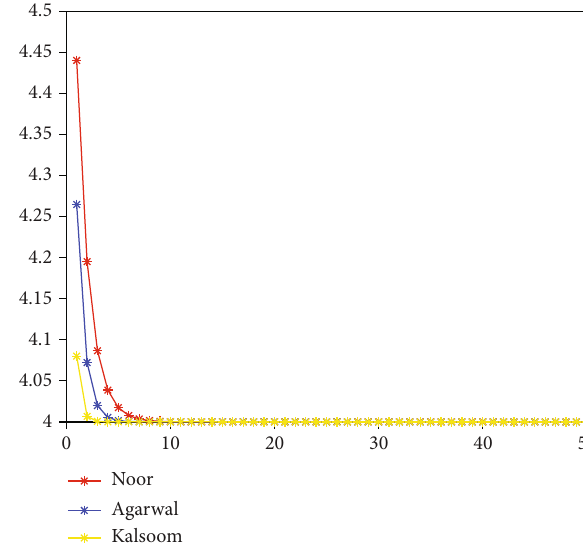
Figure 5: Convergence behavior of Noor, Agarwal, and Kalsoom et al. iterations towards fi xed point.